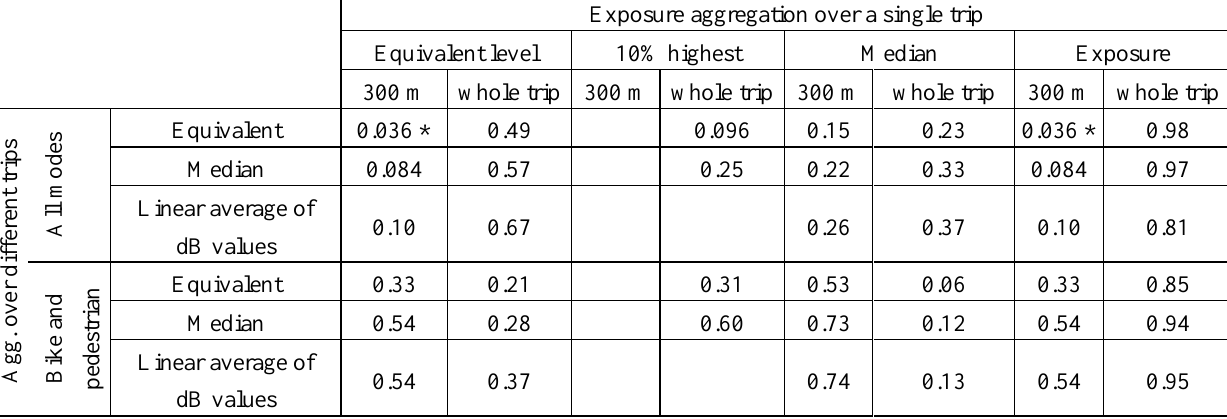
Table 4. p in chi square test for a logistic model predicting not satisfied to not at all satisfied with general quality of life of the neighborhood (Q1.1) on the basis on L most exposed façade and the additional indicator in the table. The value of p for L is